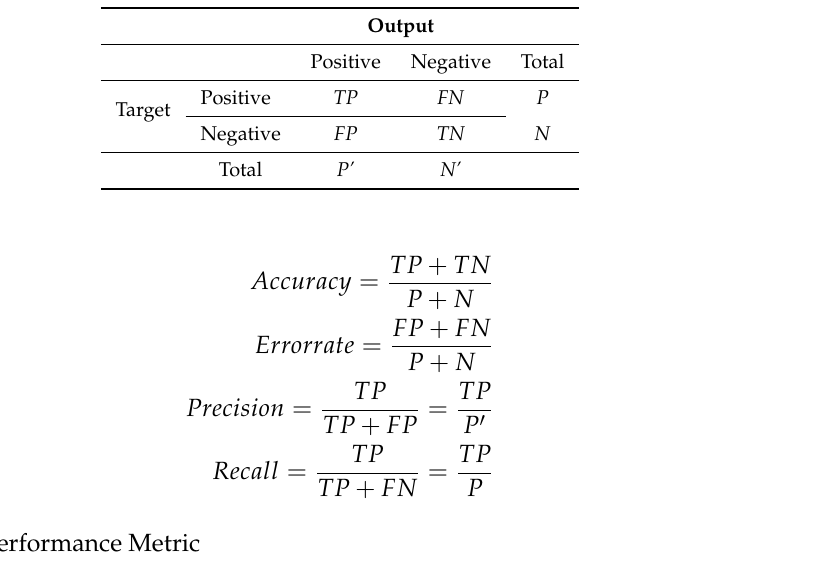
Table 4. Confusion